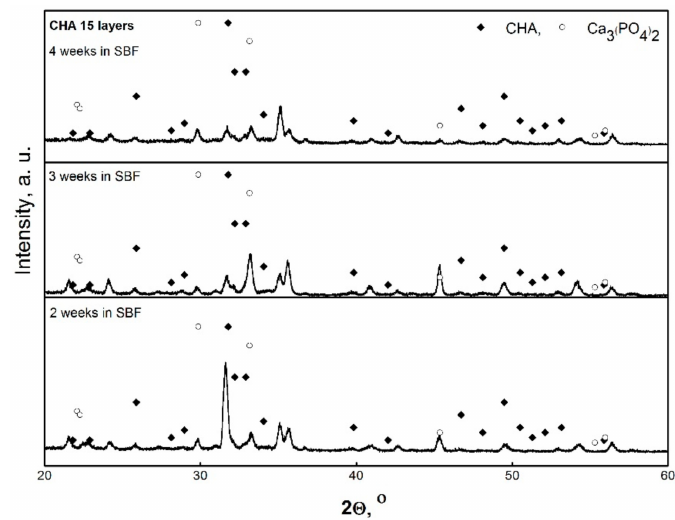
Figure 10. XRD patterns of CHA samples coated with 15 layers after immersion in SBF for 2, 3, and 4 weeks. Phase changes during one month of soaking in SBF are not monotonic.